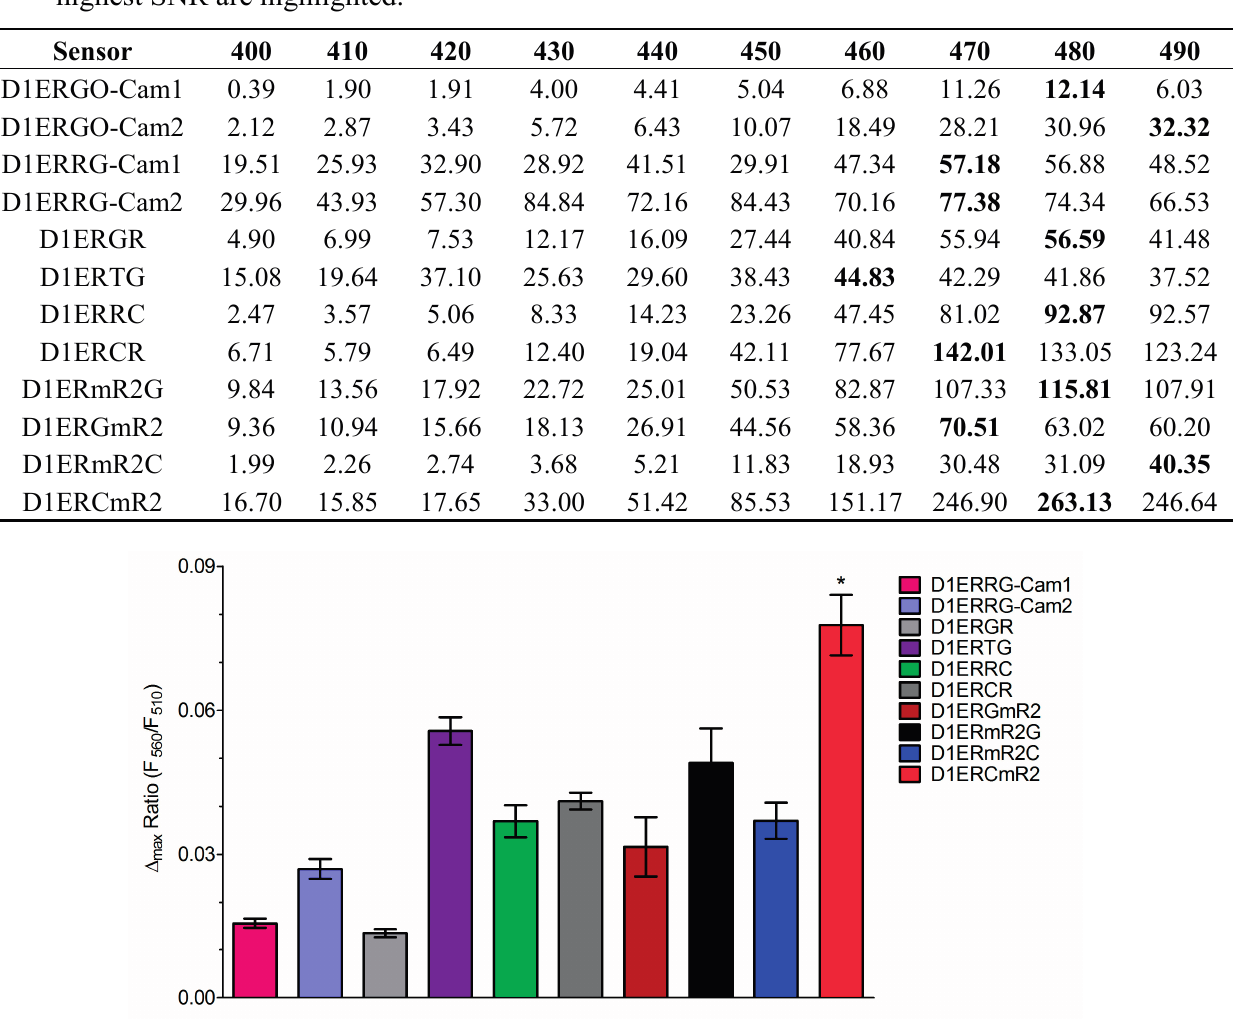
Table 2. Signal to noise ratios of various ER targeted red-shifted cameleons at stepwise increased excitation wavelengths. Optimum excitations for individual sensors resulting in highest SNR are highlighted.